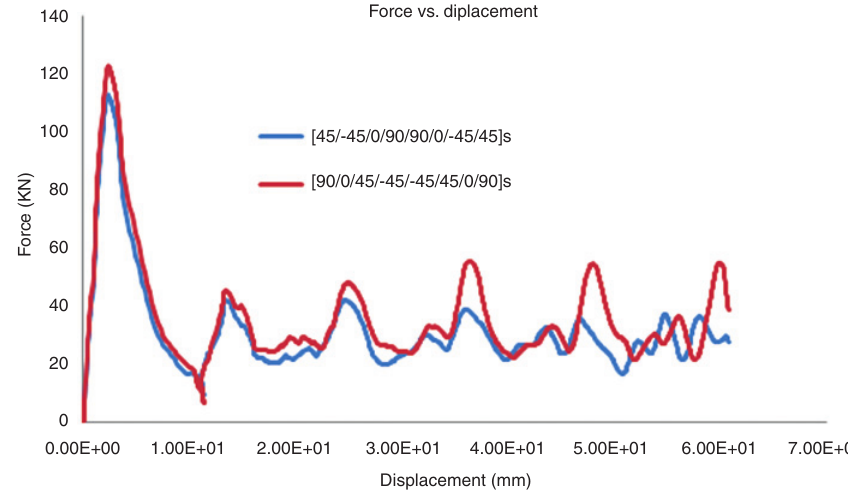
Figure 6 Force versus displacement at 11 m/s.